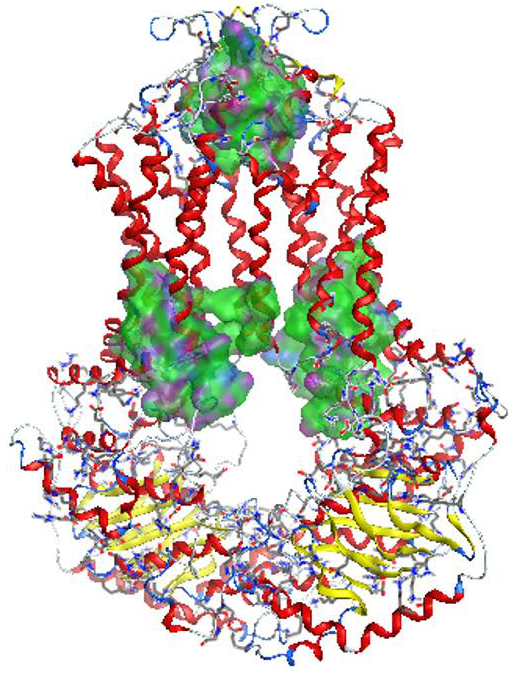
Figure 17. Binding sites determined by Site